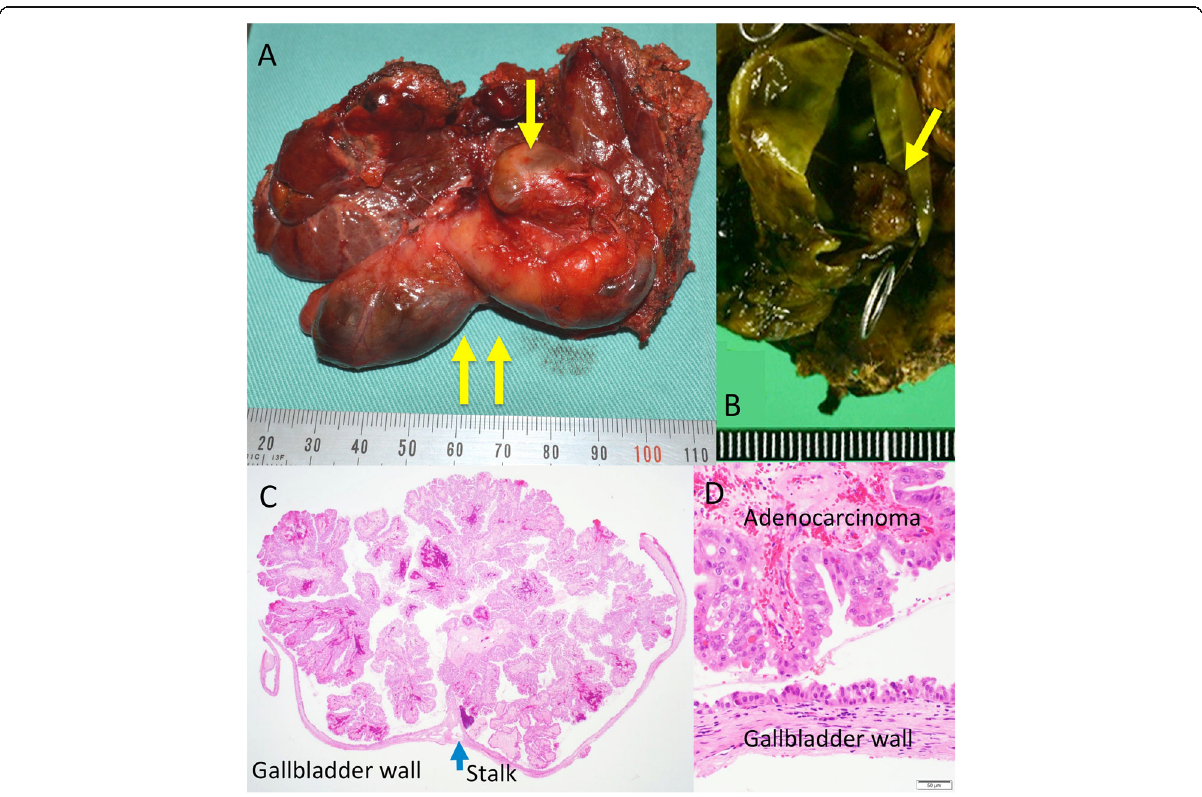
Fig. 8 Macroscopic findings and histological findings of resected specimen. a Resected fresh specimen, proximal gallbladder identified as an accessory gallbladder containing carcinoma (single arrow), and distal gallbladder identified as a primary gallbladder (double arrows). b Formalin- fixed specimen, carcinoma in the proximal gallbladder identified as an accessory gallbladder (arrow). c , d Hematoxylin and eosin (H&E) staining at original magnification (× 20 and × 100). Pedunculated and non-invasive mucosal carcinoma had a fine stalk, and there was space between